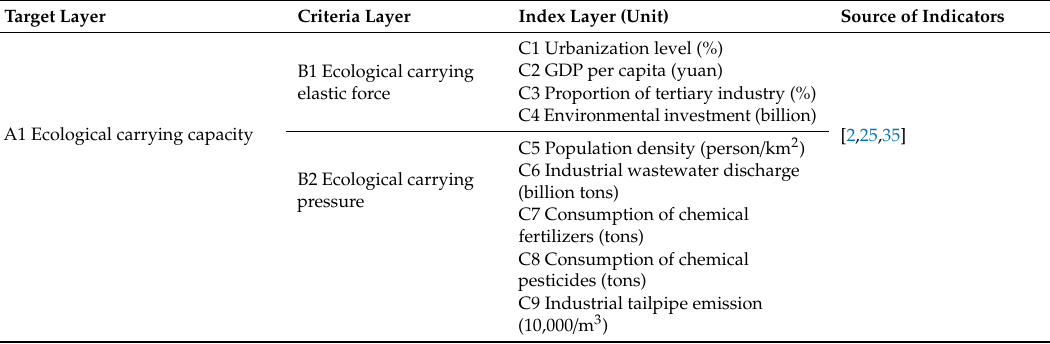
Table 1. Comprehensive evaluation index system of ecological carrying capacity for the Yangtze River urban